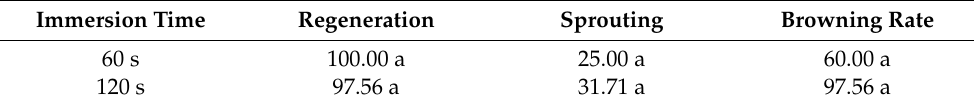
Table 4. Immersion regeneration, sprouting and browning rates 1.